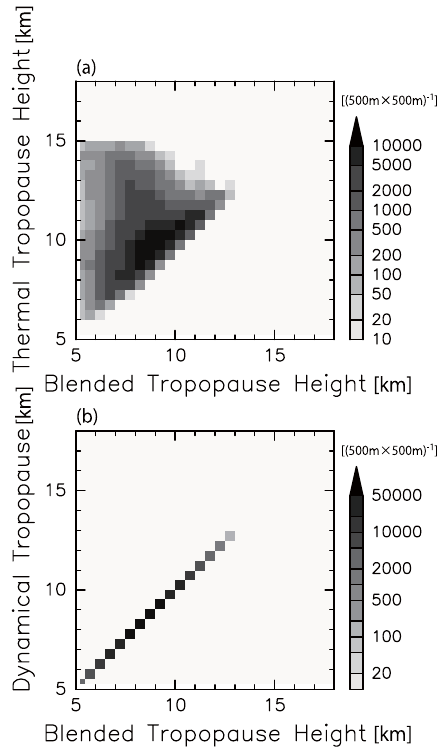
Fig. 2. (a) Two-dimensional frequency distribution of altitude for the blended and thermal tropopause in the latitude range of 60– 82 ◦ S from June through September 2007. (b) The same as (a) but for the frequency distribution of altitudes for the blended and the dynamical